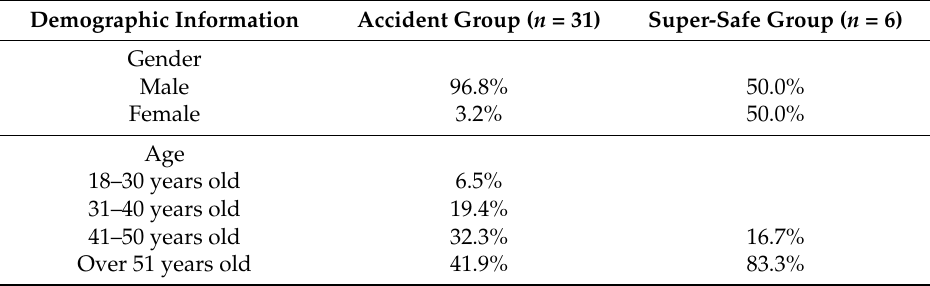
Table 2. General demographic information of accident cases and super-safe